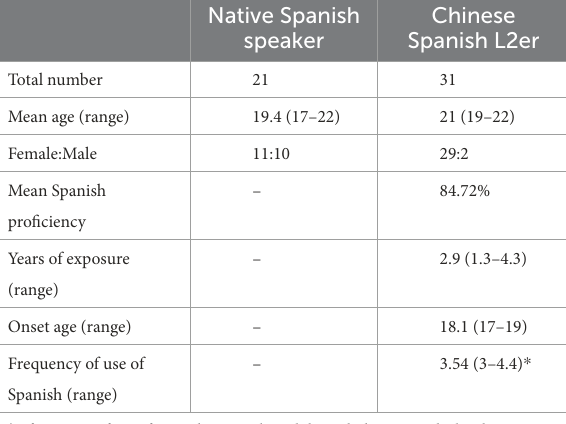
TABLE 1 Participant characteristics of the self-paced reading